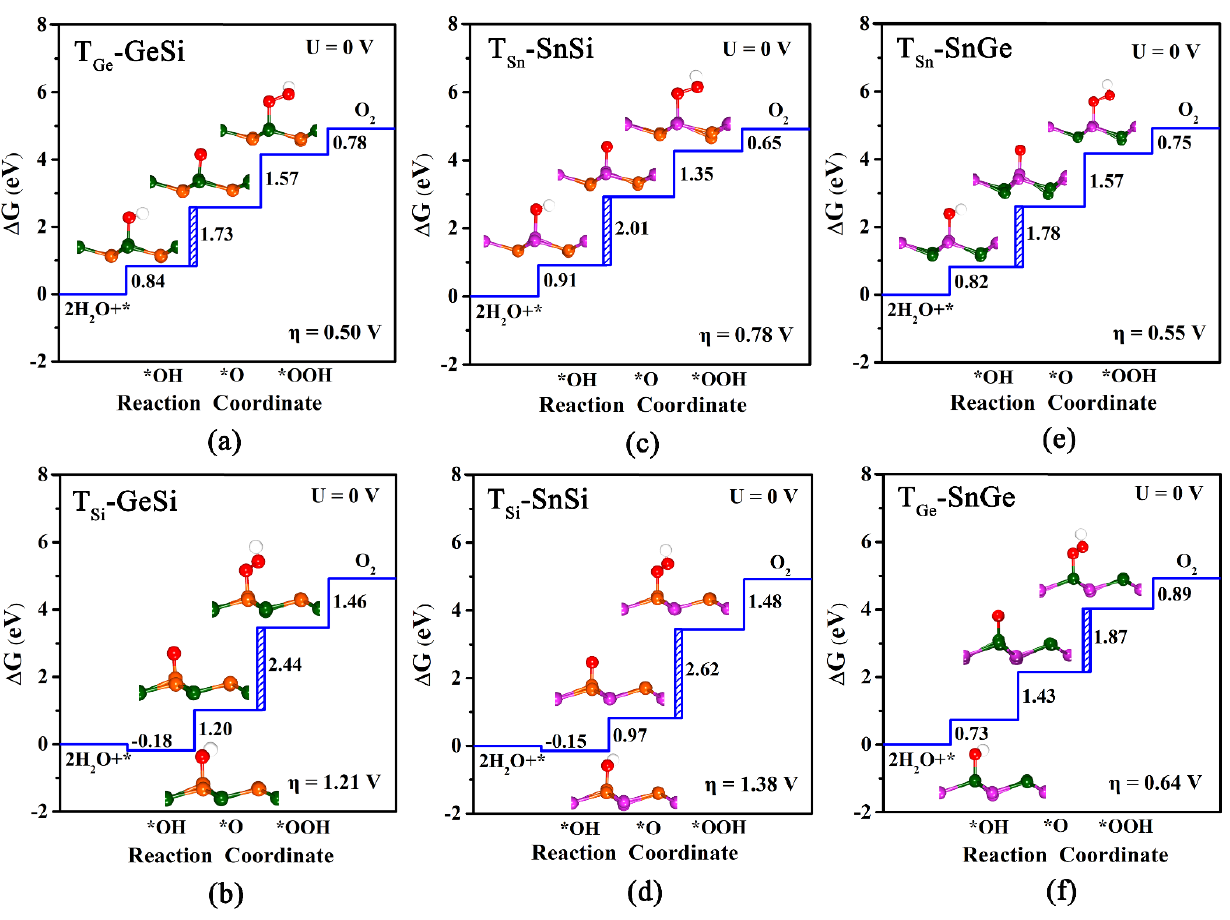
Figure 3. The calculated free energy diagram at T Ge /T Si , T Sn /T Si and T Sn /T Ge sites, and the corre- sponding configurations of adsorbed intermediates on pure GeSi ( a , b ), SnSi ( c , d ), and SnGe ( e , f ) monolayers for OER under U = 0 V. The blue dashed area represents the rate-limiting step for OER. Comparatively, the third electron transfer step, from O* to *OOH, becomes the most energy-consuming for the other sites. Specifically, the calculated η OER value of T Ge on SnGe is 0.64 V, indicating good OER catalytic activity. However, the high overpotential η OER for T Si -GeSi (1.21 V) and T Si -SnSi (1.38 V) can mean poor OER catalytic activities at the relevant Si sites, which is different from the case of HER. Clearly, the GeSi and SnGe